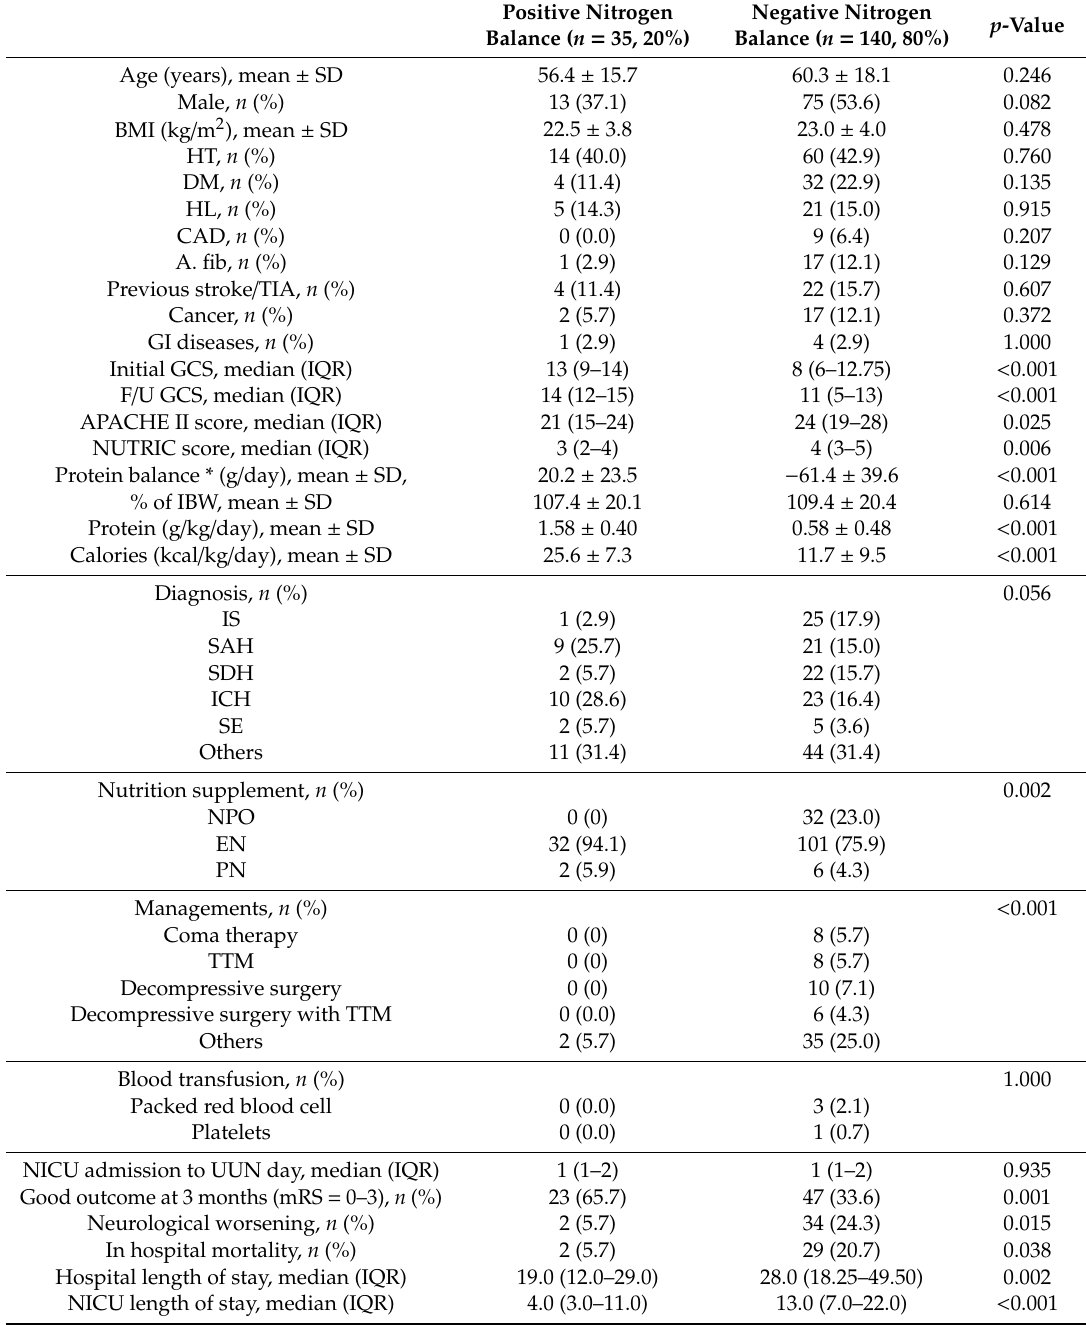
Table 1. Clinical characteristics according to initial nitrogen